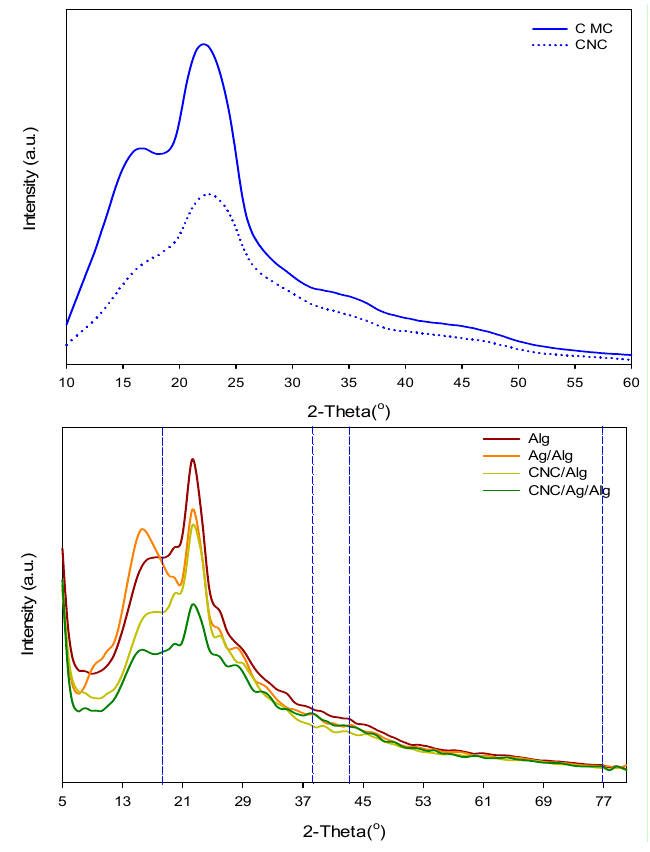
Figure 5. XRD patterns of CMC, CNC, Alg, Ag/Alg, CNC/Alg, and CNC/Ag/Alg samples.